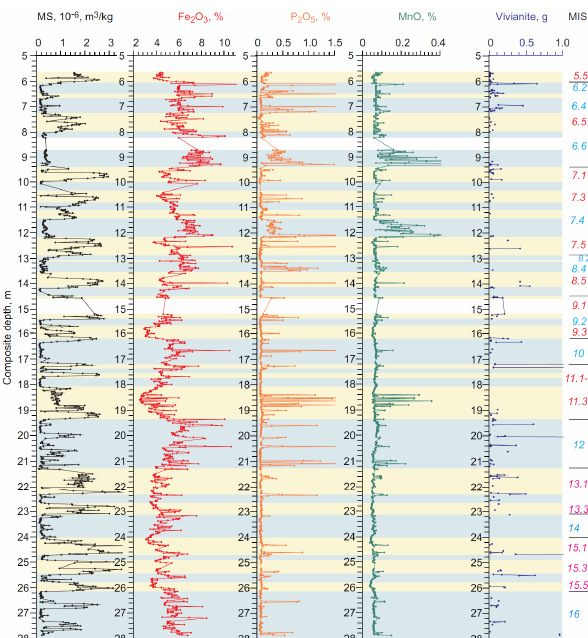
Fig. 3. Distribution of magnetic susceptibility (MS), percent of Fe 2 O 3 , P 2 O 5 , and MnO, and occurrence of vivianite nodules, in grams, in sediment samples over 28m of core material. Marine iso- tope stages (MIS) adapted from Bassinot et al. (1994). Blue (yellow) bars indicate cold (warm) stages.